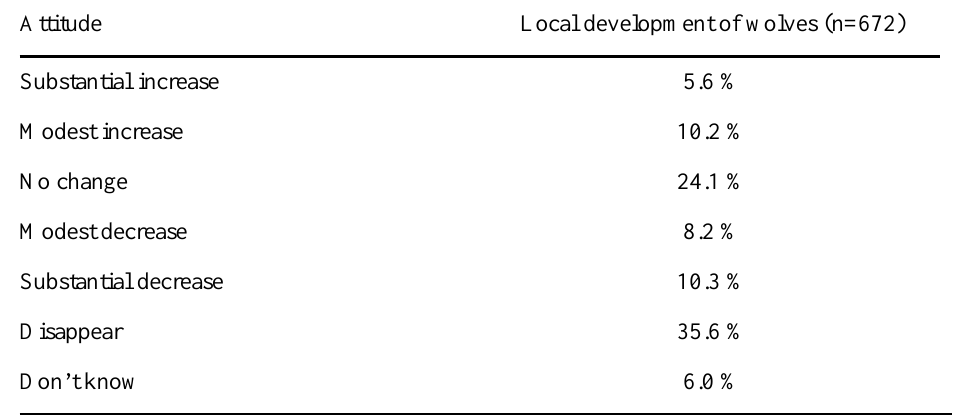
Table 3. Attitudes toward wolves, measured as the frequencies of supported scenarios of wolf population trends in the wolf territory where the respondent